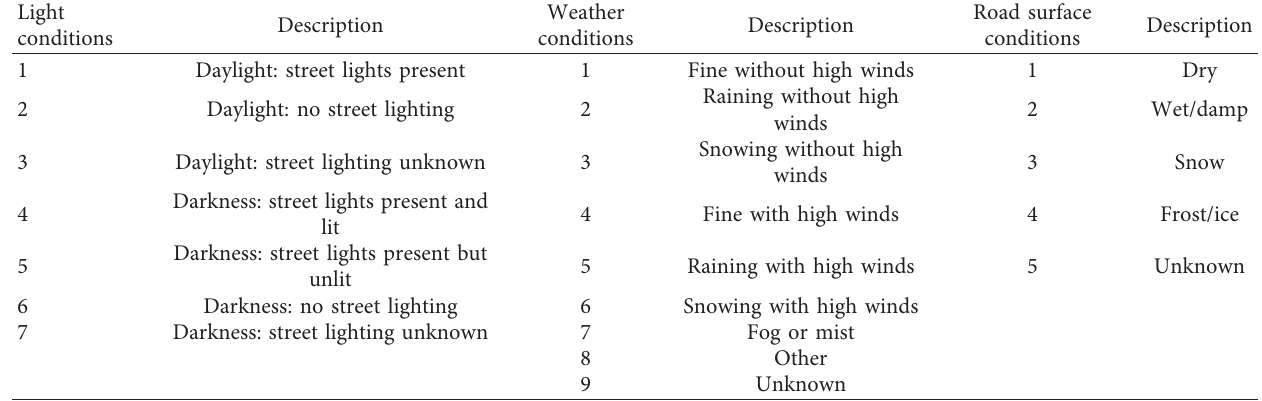
Table 1: Categorization criteria of several features.